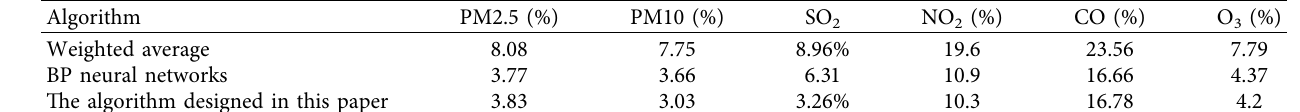
Table 1: Average error of three algorithms in data fusion.